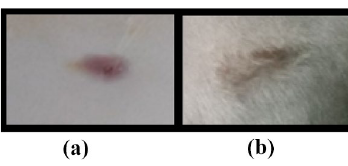
Fig. 20 a Healed wound from [12] b Healed wound of current study